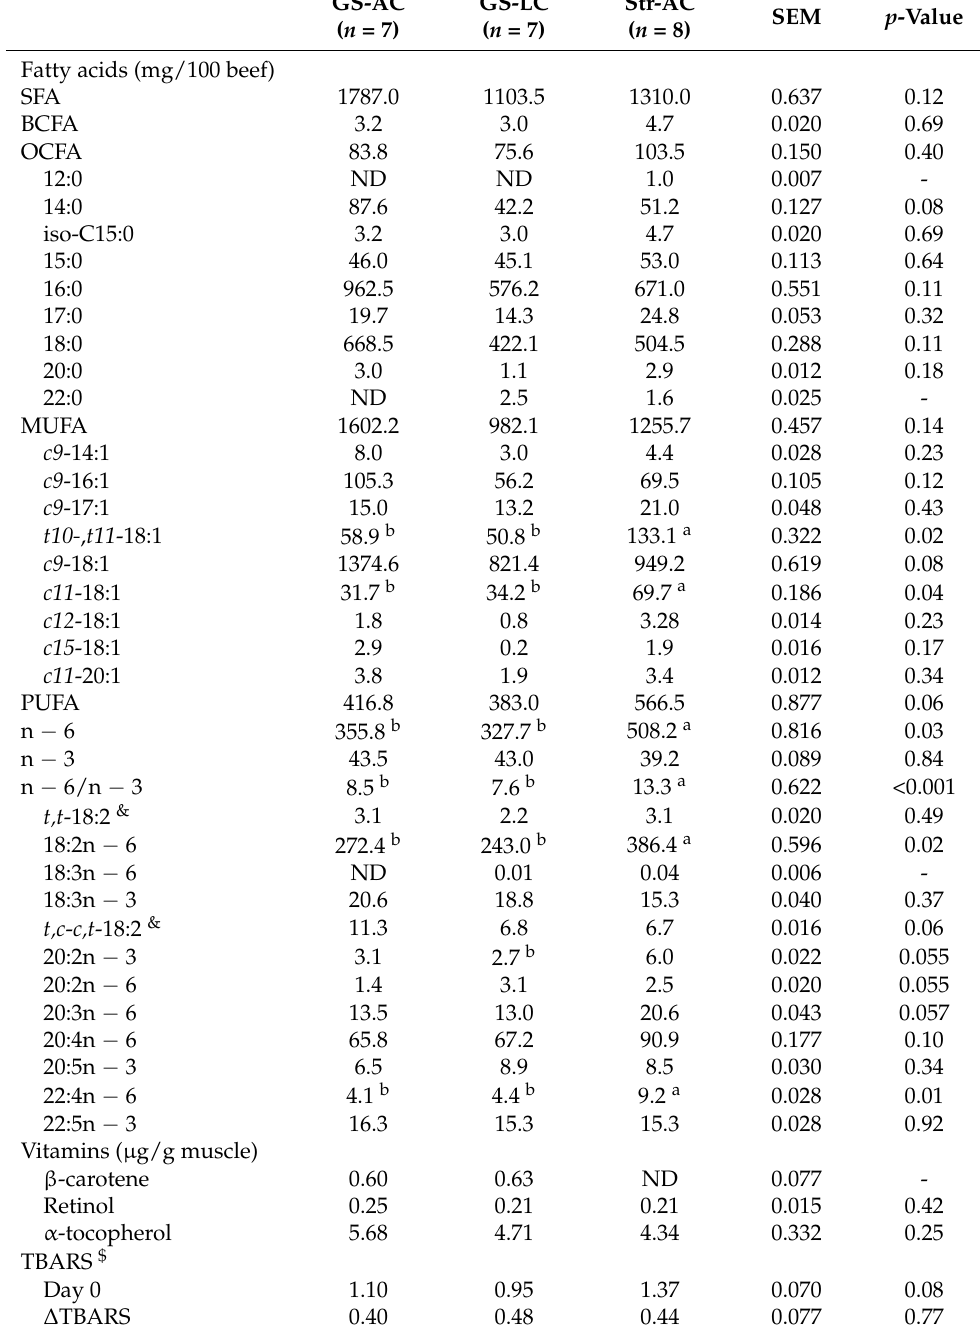
Table 2. Fatty acids (FA), fat-soluble vitamins and oxidation stability in longissimus thoracis muscle from young Tudanca bulls reared on different feeding